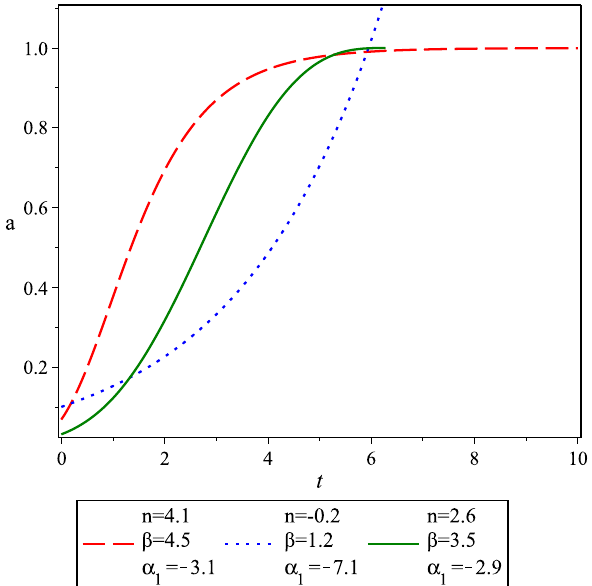
Fig. 1 Typical evolution of the scale factor versus the cosmic time in f ( R , T ) = R + β T with potential V (φ) = q φ n and for some selected values of n , β and α 1 . To plot this figure we have set α 2 = − 1 . 9 and q = 1. The blue curve (dotted-line) shows the intermediate scale factor for φ i =